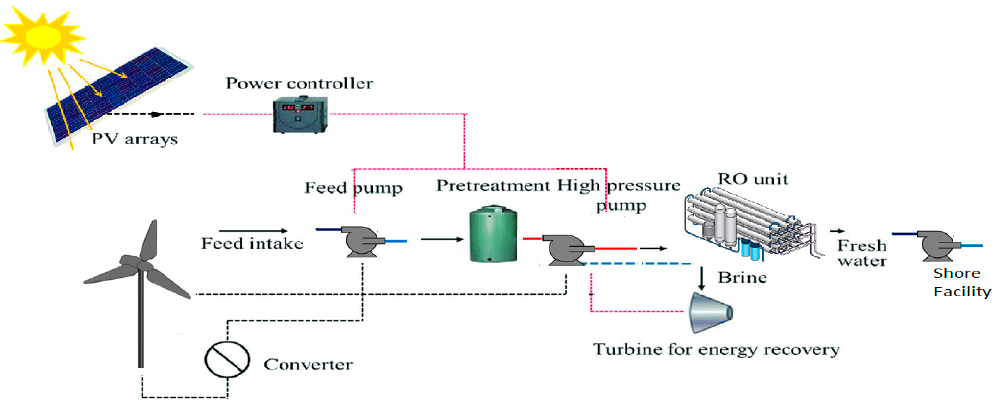
Figure 9. Block diagram of the integrated solar–wind-driven desalination system used in the FDP.